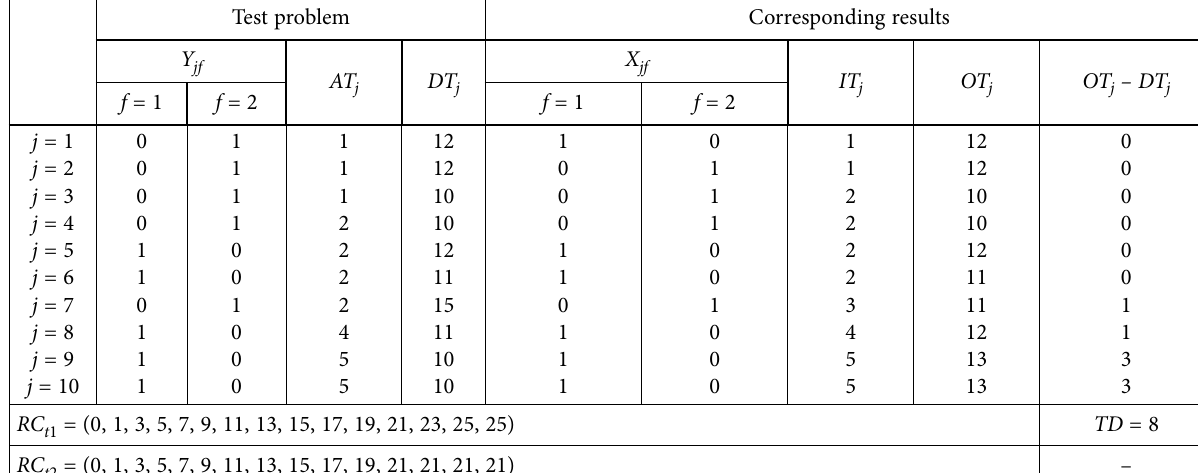
Table 4. An example of a test problem and its corresponding